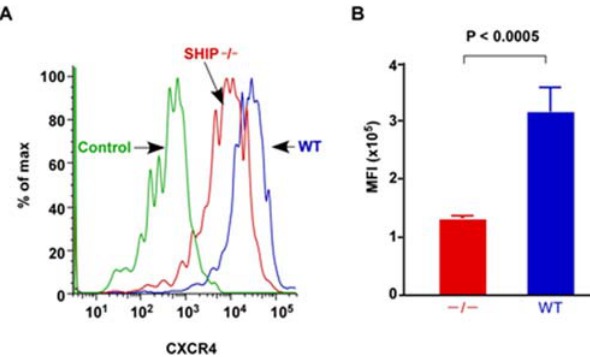
Figure 3. SHIP deficient mice MK are redistributed within hematopoietic organs. (A) Represented are the mean 6 SEM (n=4 for experimental groups WT C57Bl6 and SHIP 2 / 2 , while n= 6 for experimental groups WT 129SvJ and SHIP D IP/ D IP ) of the absolute numbers of MK (Lin 2 c-Kit 2 CD41 + ) in BM, spleen and PB of SHIP deficient mice (black columns) compared to respective WT littermates (gray columns). Mice strains specified in the graphs. (B) Represented is the mean 6 SEM (n=4 for experimental groups WT C57Bl6 and SHIP 2 / 2 , while n=6 for experimental groups WT 129SvJ and SHIP D IP/ D IP ) of total body numbers of MK determined as the calculated sum of MK numbers